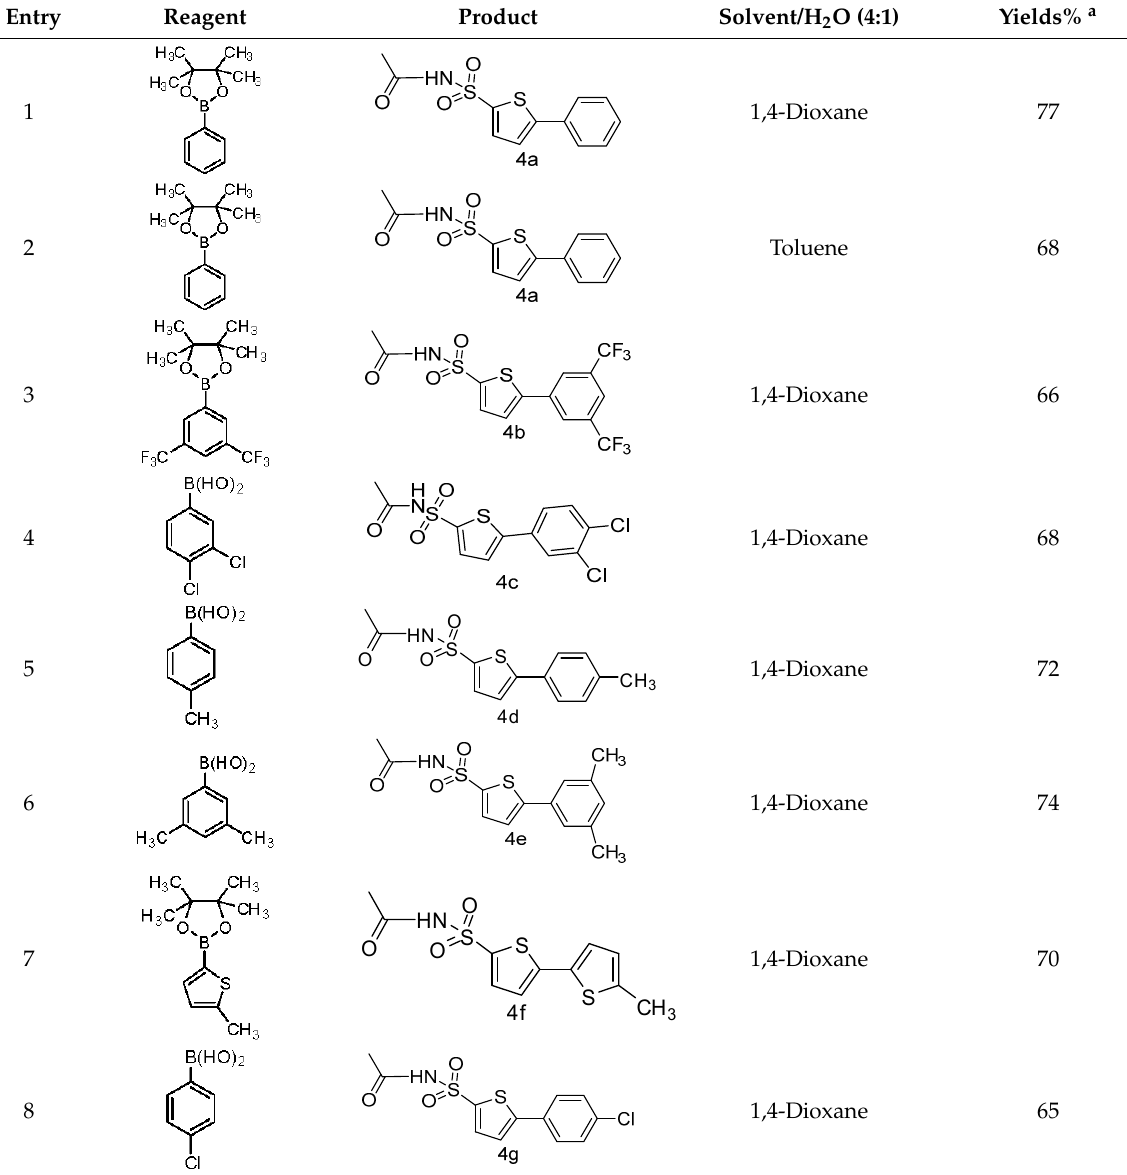
Table 1. Synthesis of 5-arylthiophene-2-sulfonylacetamide 4a – g .